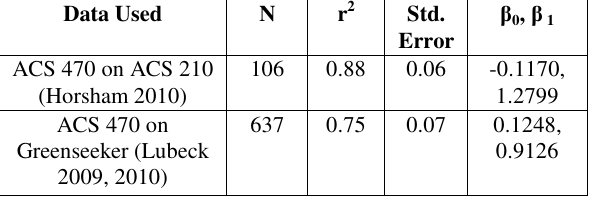
Regression of NDVI values between sensors 3.2 Comparison of NDVI with Fractional Green Cover